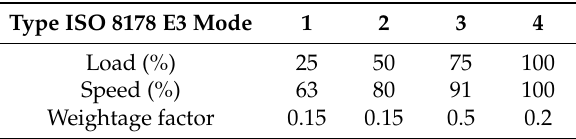
Table 4. ISO 8178 marine Diesel engine test cycle E3.